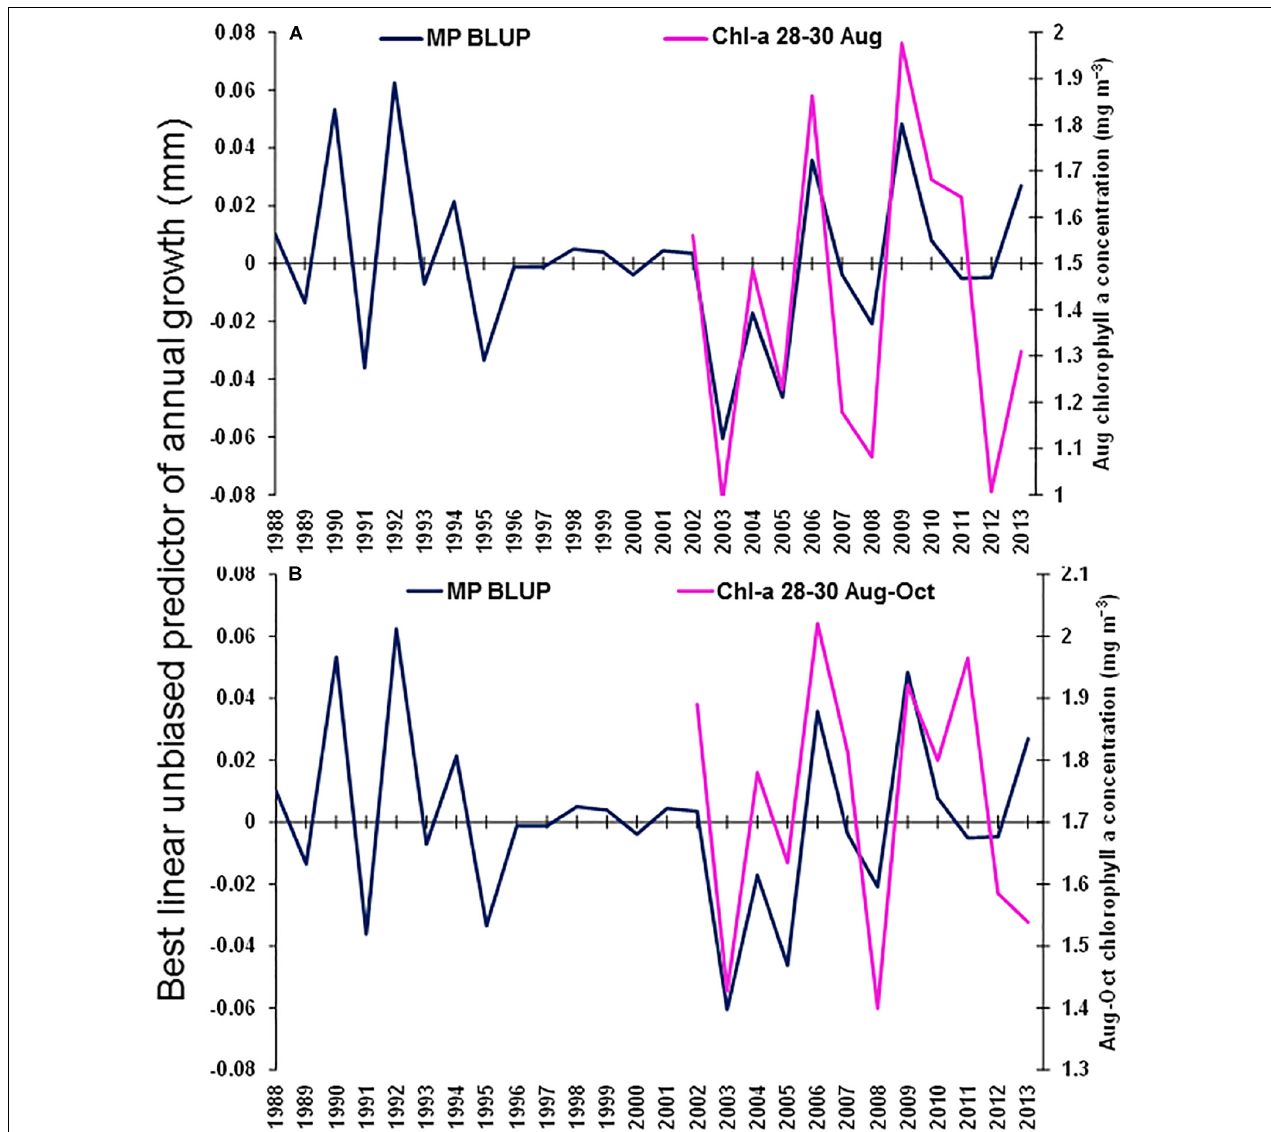
FIGURE 8 | Merluccius paradoxus (MP) caught in Namibia best linear unbiased predictor (BLUP) of annual growth from otolith increments (blue) and (A) August mean chlorophyll-a concentration (Chl-a 28–30 August); and (B) August to October mean chlorophyll-a concentration (Chl-a 28–30 August–October); both in the area –28.0 to –30.0 latitude and 11.0 to 17.0 longitude